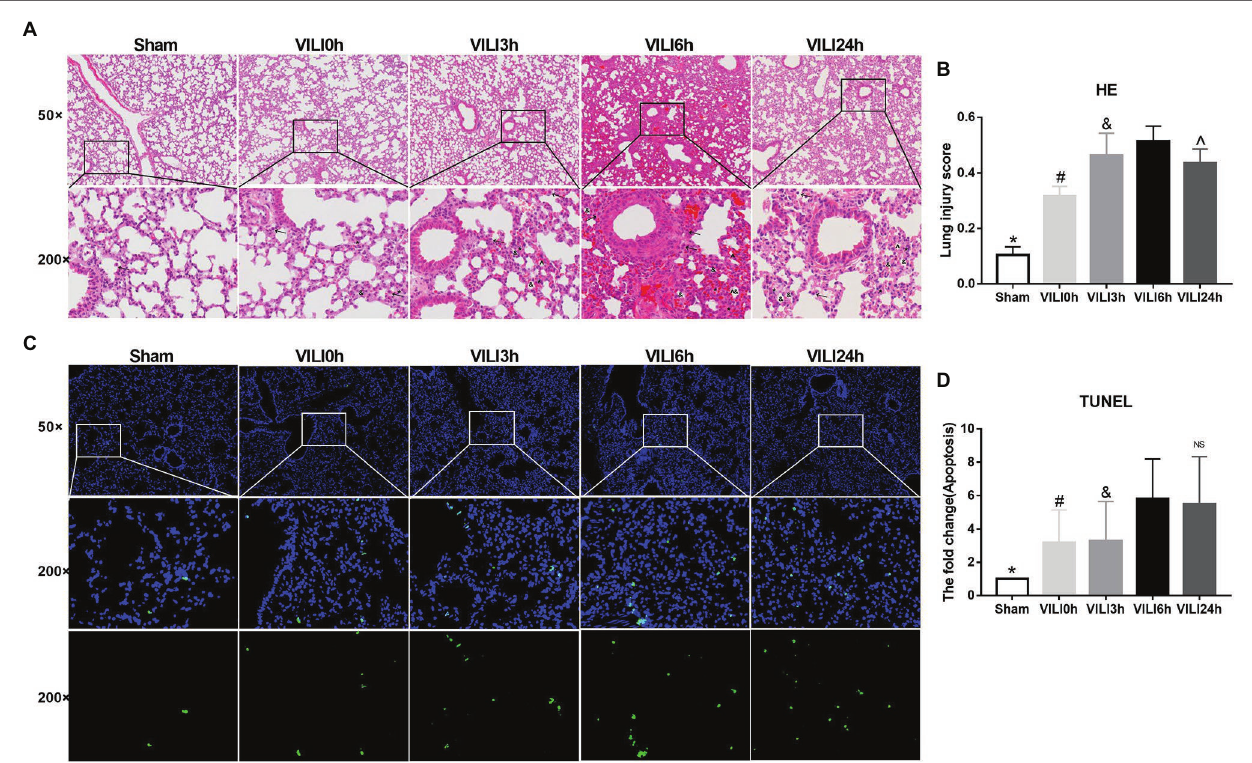
FIGURE 2 | Identification of the VILI model induced by high-tidal volume mechanical ventilation. (A) HE staining of lung tissue in each group. Figure marker: → , macrophage; ^, alveolar hemorrhage; *, alveolar wall thickening; and &, Alveolar collapse. (B) Lung injury scores of lung tissue in each group, n = 3. (C) TUNEL staining of lung tissue in each group. (D) Apoptosis of lung tissue in each group after, n = 3. Bars represent means ± standard deviation. VILI. Ventilator-induced lung injury. HE. hematoxylin and eosin. TUNEL. TdT-mediated dUTP Nick-End Labeling. * p < 0.05 VILI 6 h vs. sham, # p < 0.05 VILI 6 h vs. VILI 0 h, & p < 0.05 VILI 6 h vs. VILI 3 h, ^ p < 0.05 VILI 6 h vs. VILI 24 h, and ns p > 0.05 VILI 6 h vs. VILI 24